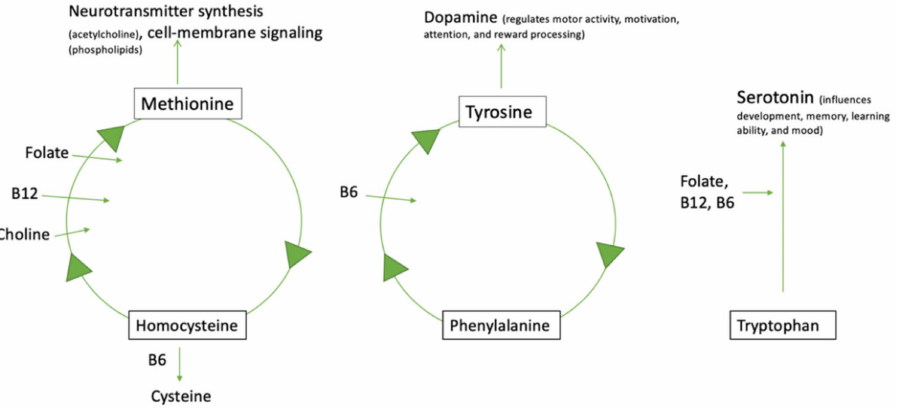
Figure 1. The interrelationship between choline, B vitamins, amino acids, and important neurotrans- mitters in